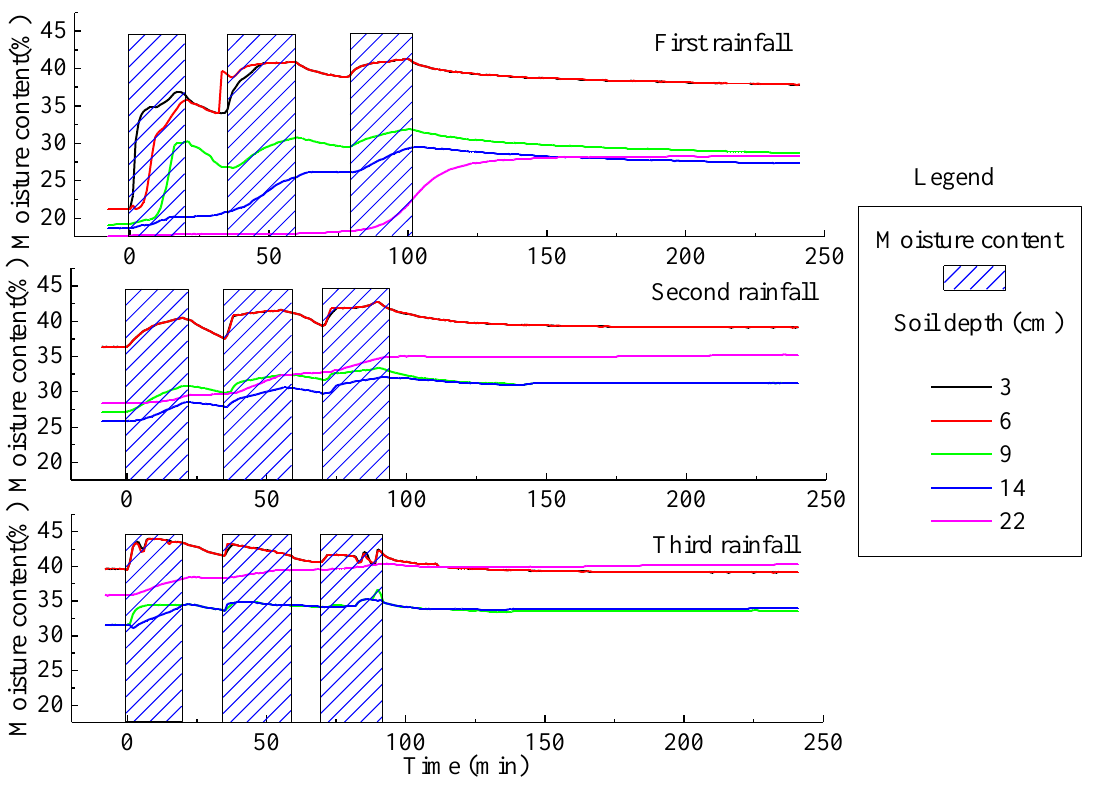
Figure 8. Dynamic change process of soil water content of the loess slope at a rainfall density of 1.5 mm/min.